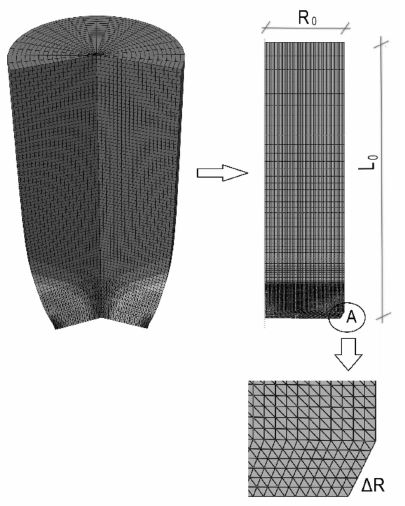
Figure 1. General geometry and meshing in the first numerical study.